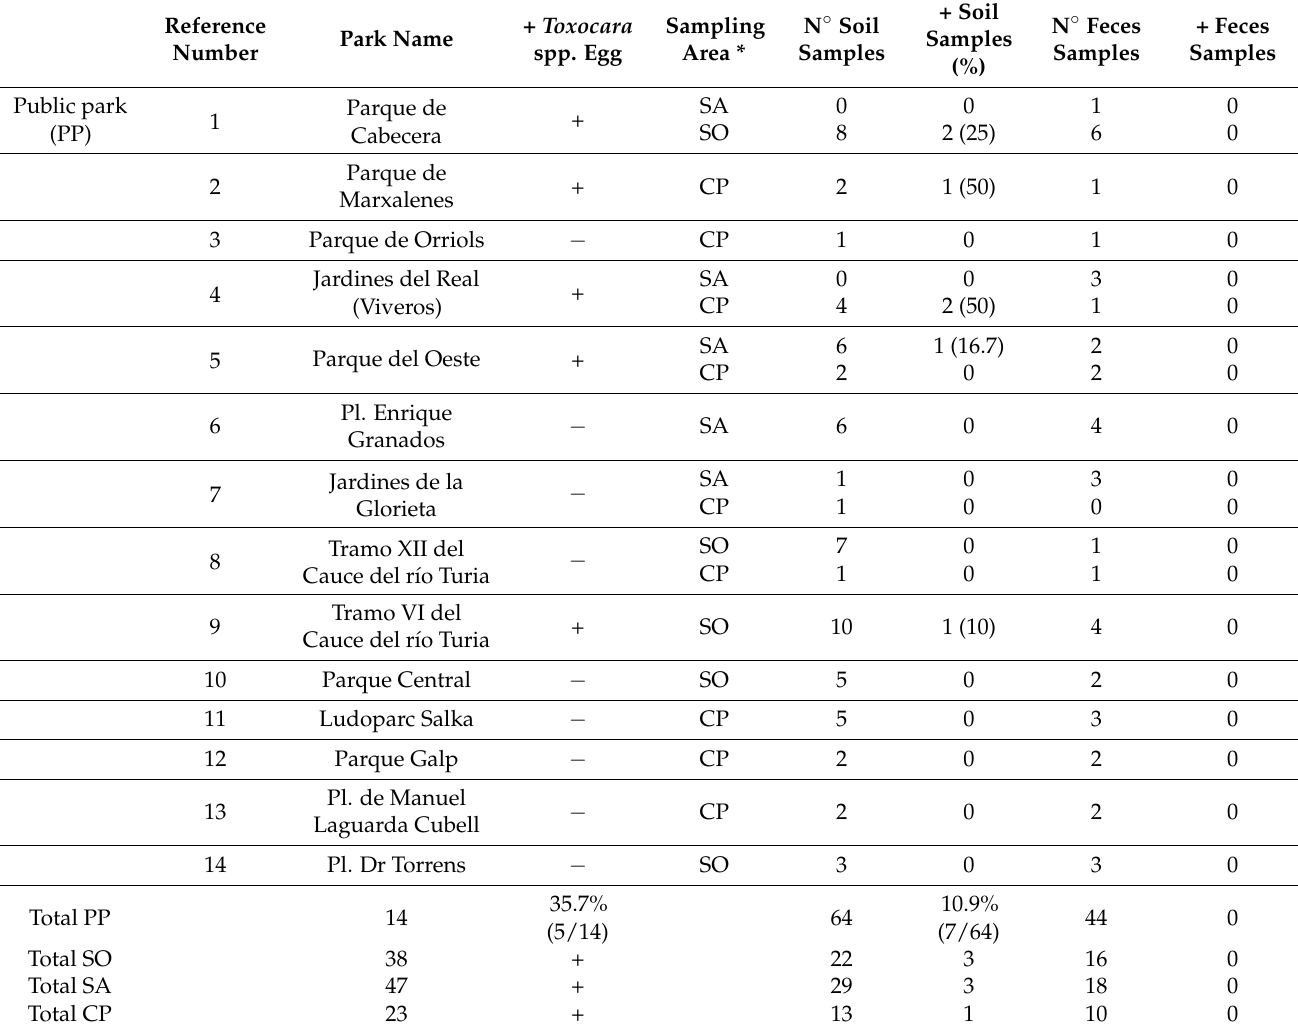
Figure 1. Map of the metropolitan area of Valencia, highlighting the positive (red stars) and negative (blue circles) parks to Toxocara spp. eggs. Numbers inside correspond to references to the park ac- cording to Table 1. Table 1. Prevalence of Toxocara spp. eggs in soil and feces from parks in Valencia. Distribution of positive samples regarding the area of collection.